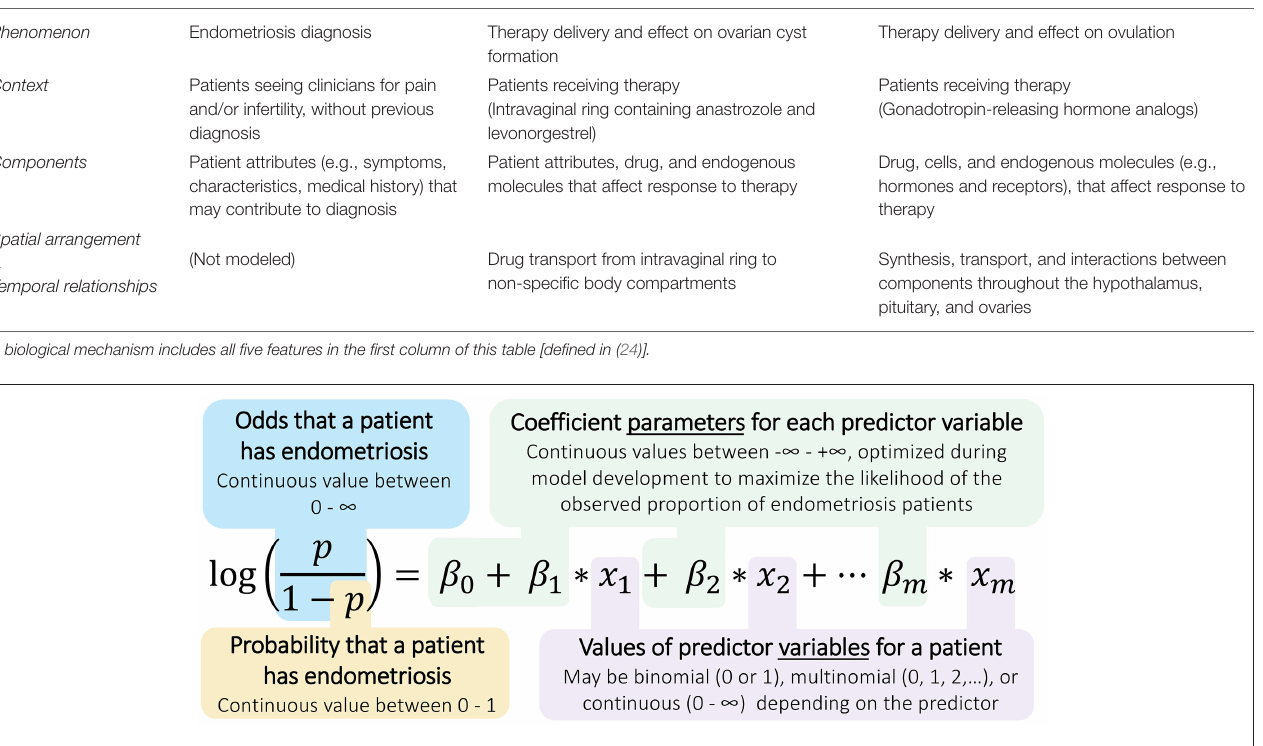
FIGURE 1 | Structure of logistic regression models for diagnosing endometriosis. Logistic regressions calculate the odds and probability of a binary outcome (e.g., positive endometriosis diagnosis) using measurements taken across several predictor variables (e.g., patient observations). The model parameters, the β coefficients, are identified by applying the logistic regression model to a many-patient data set for whom the outcomes are known, and these coefficients can then be used with new patient data to predict the likelihood of endometriosis in that patient.